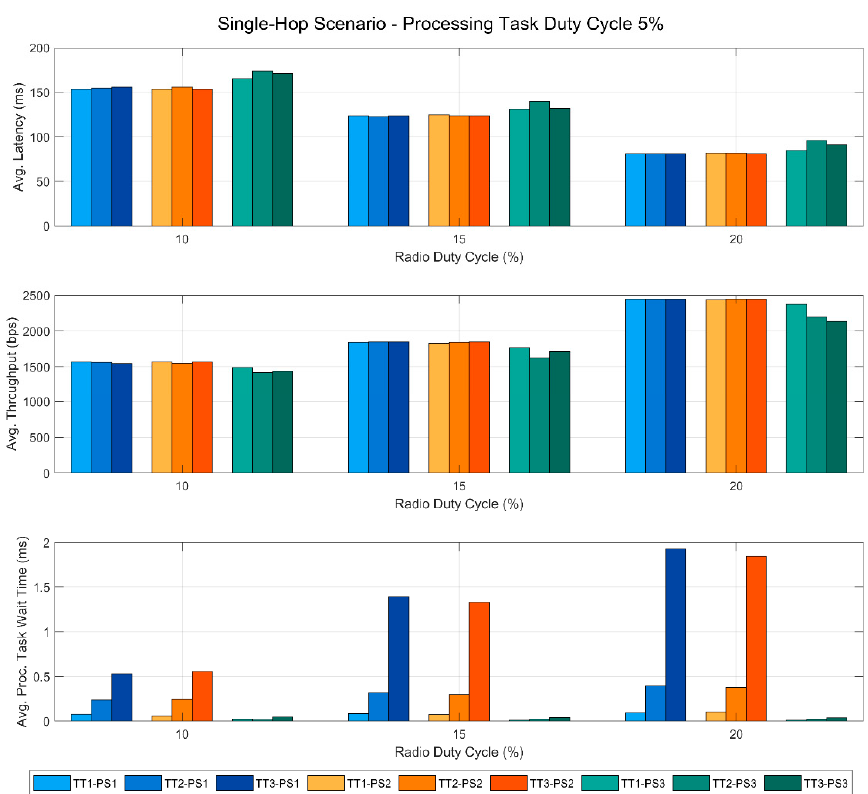
Figure 6. Single-hop scenario with a fixed Processing Task Duty Cycle of 5%.